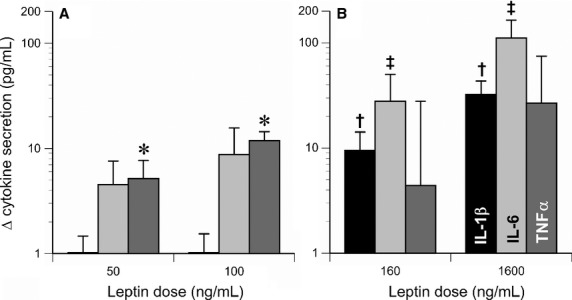
Leptin‐induced increases in IL‐1β, IL‐6 (light gray bars), and TNFα (dark gray bars) in vitro. (A) Responses to physiological doses of leptin by mononuclear cells isolated from the first cohort of subjects (n = 34, *P < 0.0001 by repeated measures ANOVA). (B) Responses to supraphysiological doses of leptin by mononuclear cells isolated from the second cohort of subjects (n = 11, †P = 0.003, ‡P = 0.025 by repeated measures ANOVA).